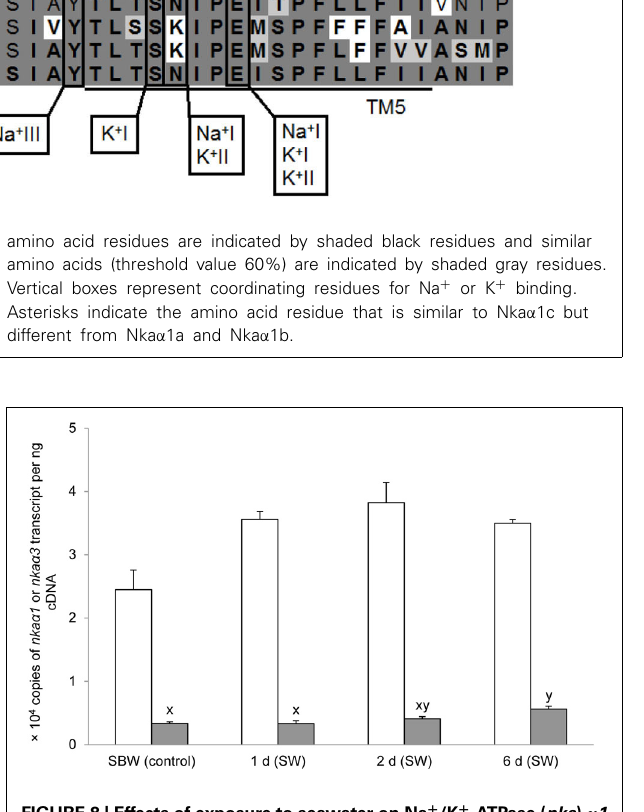
FIGURE 7 | Effects of exposure to ammonia in slightly brackish water on Na + /K + -ATPase ( nka ) α 1 and nka α 3 mRNA expression. Absolute quantification (copies of transcript per ng cDNA) of nka α 1 ( (cid:2) ) and nka α 3 ( (cid:3) ) in gills of Periophthalmodon schlosseri kept in slightly brackish water (SBW; salinity 3) for 2 weeks (control), or after 1, 2, or 6 days of transfer from SBW to SBW containing 75mmol l − 1 NH 4 Cl. Results represent mean + s.e.m. ( N = 4). Means not sharing the same letter are significantly different ( P < 0 . 05).